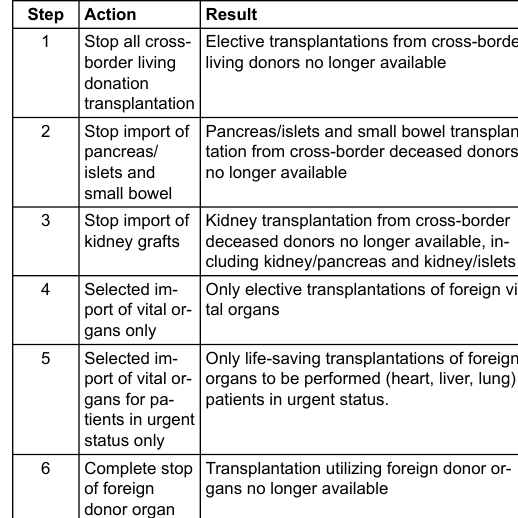
Table 3: The steps of the “Swiss COVID-19 pandemic stepwise shut- down approach” that were applied to cross-border organ